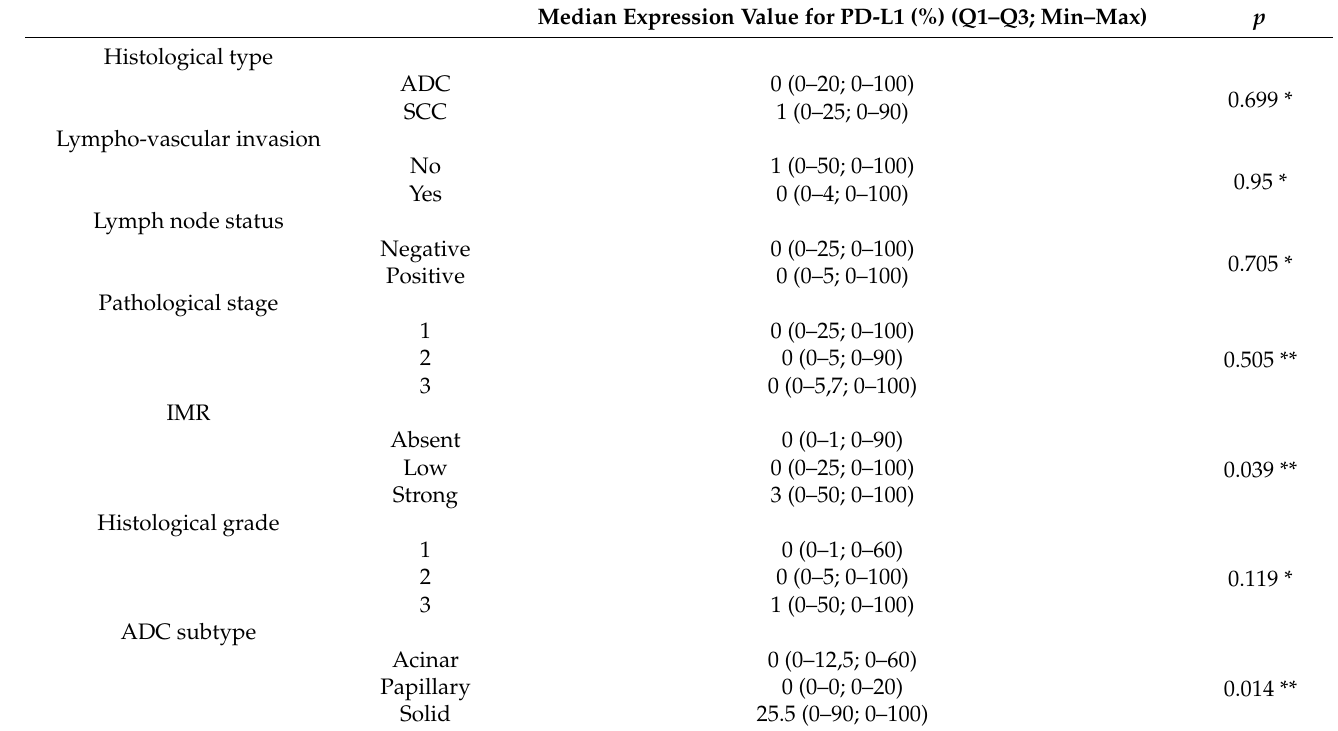
Table 2. The correlation between analysed variables and the median value for PD-L1 expression.